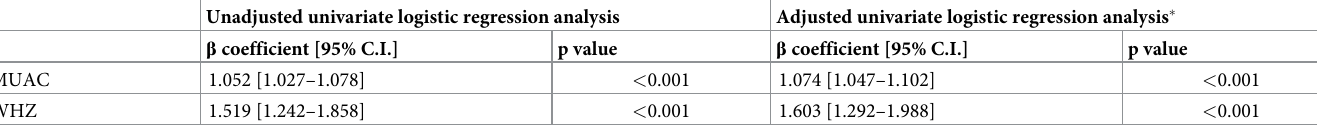
Table 4. Association of anthropometric measurements at admission with the probability of cure at discharge. Unadjusted univariate logistic regression analysis Adjusted univariate logistic regression analysis � β coefficient [95%